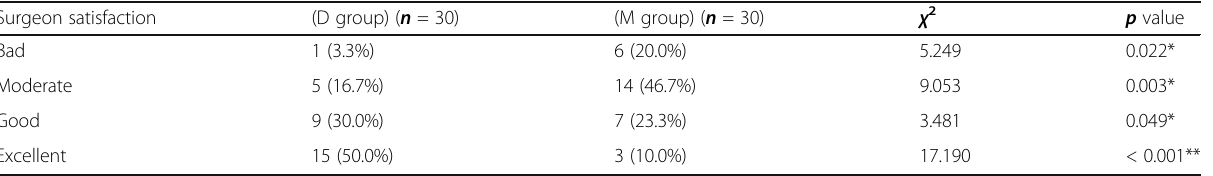
Table 7 Comparison between both groups regarding surgeon satisfaction Surgeon satisfaction (D group) ( n = 30)